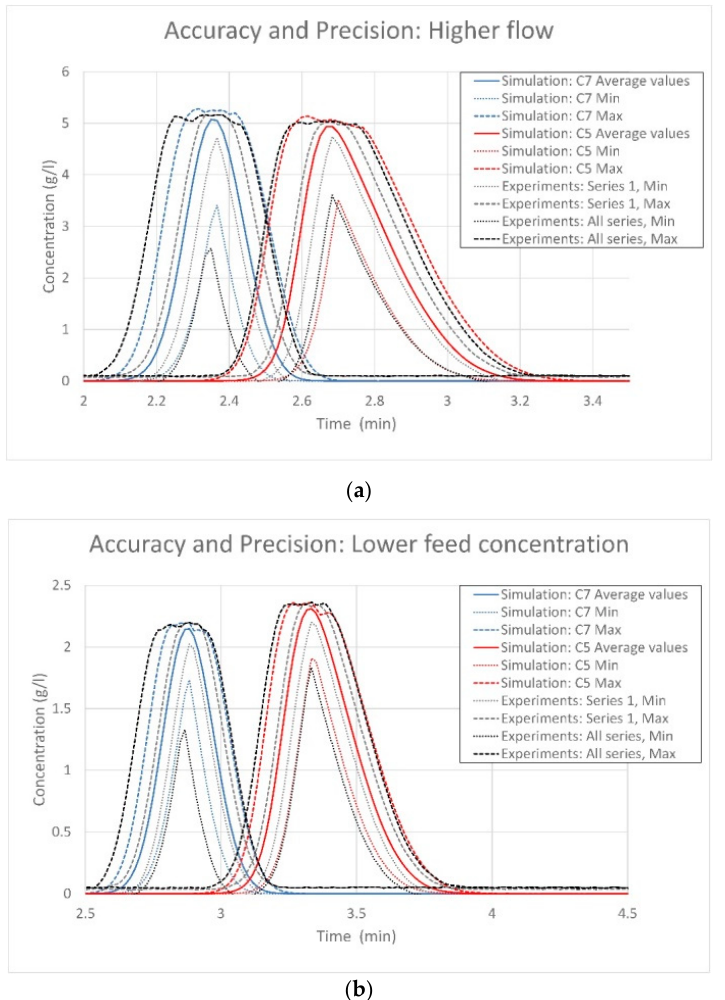
Figure 10. Comparisons between simulations and experiments for ( a ) a higher flow rate of 15 mL/min and ( b ) a feed concentration of 31.25 g / L cycloheptanone and 46.875 g / L and ( b ) a feed concentration of 31.25 g/L cycloheptanone and 46.875 g/L cyclopentanone. Step 4